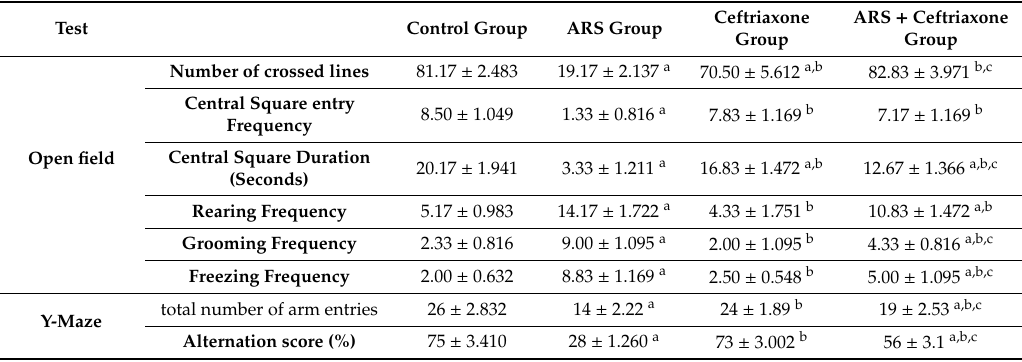
Table 2. Performance in open field and Y-maze tests in the studied groups.